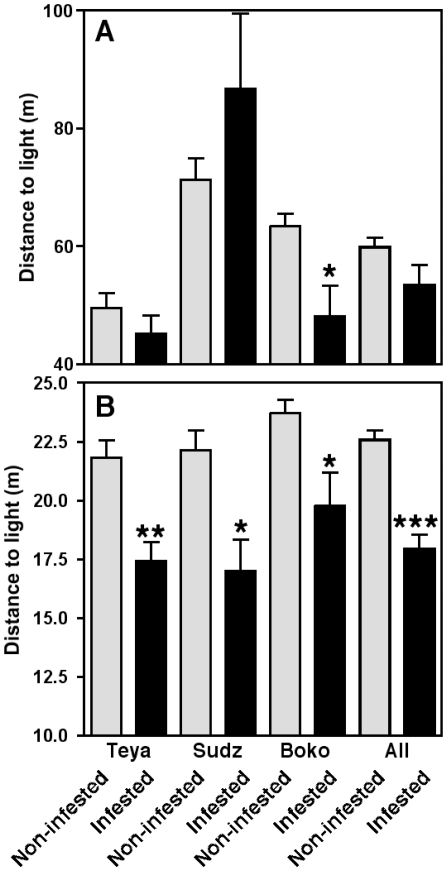
Observed distance from houses to the nearest light according to their infestation status.(A) Distance to the nearest peridomicile light of infested (black bars) and non-infested houses (light gray bars). (B) Distance to the nearest public street light of infested and non-infested houses. Data are presented as mean ± SEM. *, **, and *** indicate a significant difference between infested and non-infested houses (P<0.05, <0.01 and <0.001, respectively).